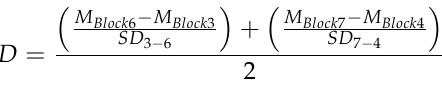
Figure 2. S tructure of the seven blocks in the IAT administered to the two groups of participants (Order 1, Order 2) in Experiment 1 (see text for